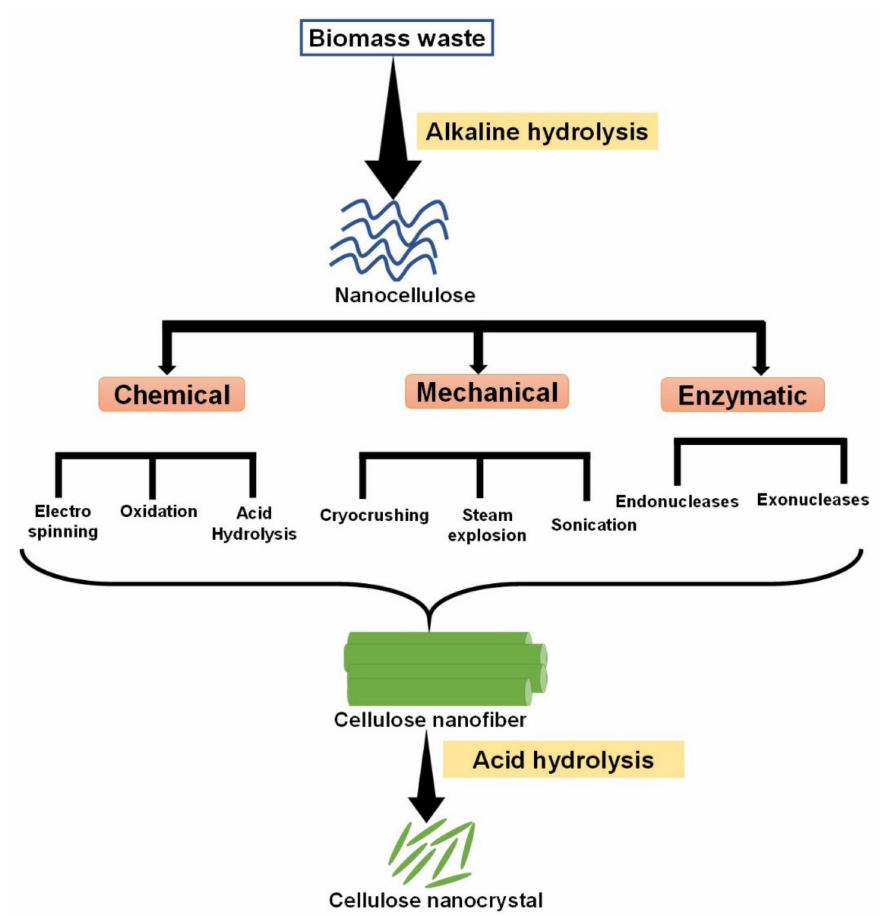
Figure 2. Different schemes for making cellulose nanocrystals